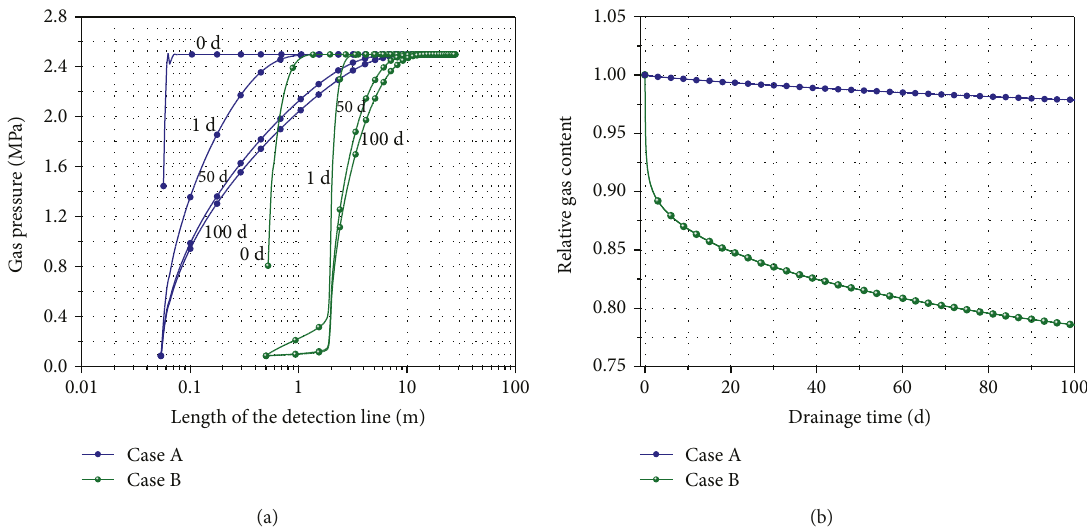
Figure 10: Case (a) and case (b): gas pressure and relative gas content distributions around a borehole.